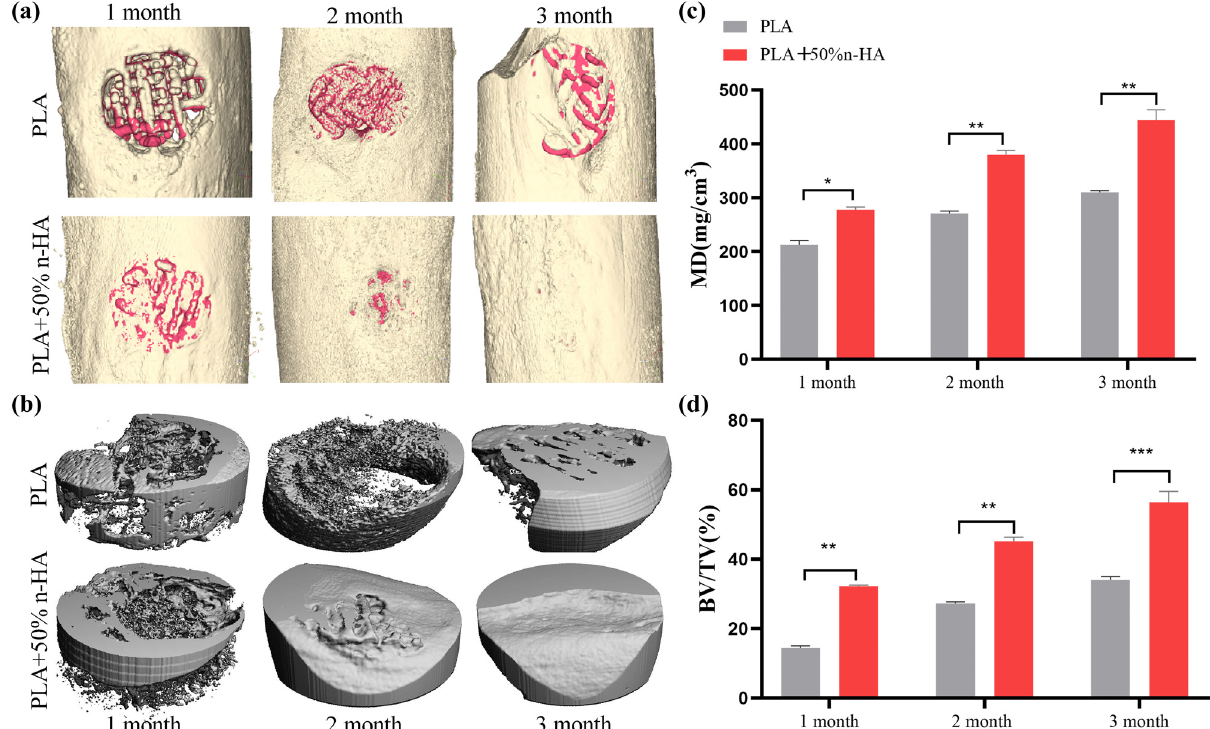
Figure 9: Micro - CT analysis of the implanted sca ff olds. The PLA and PLA/n - HA composite sca ff olds were implanted into the defect of the rabbit femoral. ( a ) At 1, 2, and 3 months after sca ff old implantation, the bone defect area was scanned using micro - CT, and 3D recon - struction was performed. The reconstructed sca ff old was shown in red and the bone in gold; ( b ) the sca ff old - implanted area of the cortical bone ( 5 mm in diameter and 2 mm in depth ) was reconstructed in 3D; and ( c and d ) quantitative calculation of new bone growth based on CT data, mineral density ( MD ) , and bone tissue volume ( BV ) /total tissue volume/ ( TV ) . * p < 0.05; ** p < 0.01, *** p < 0.001.